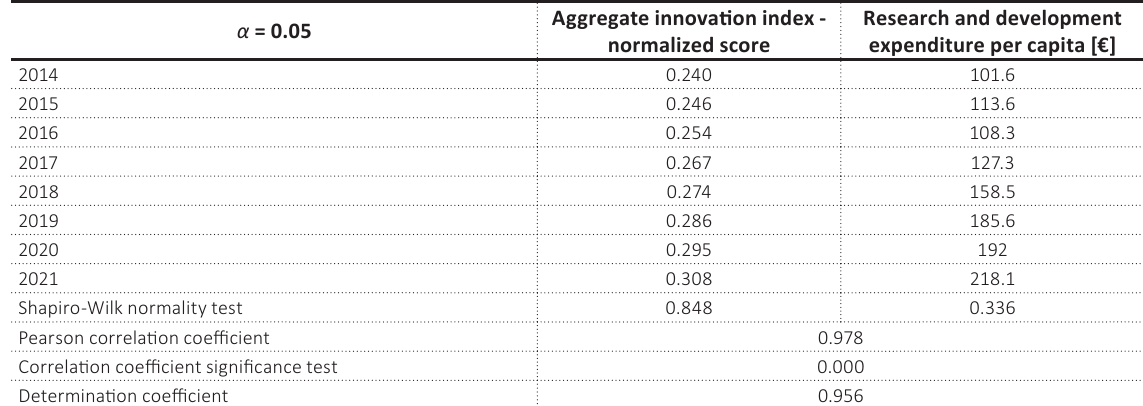
Table 3. Test statistics – Poland